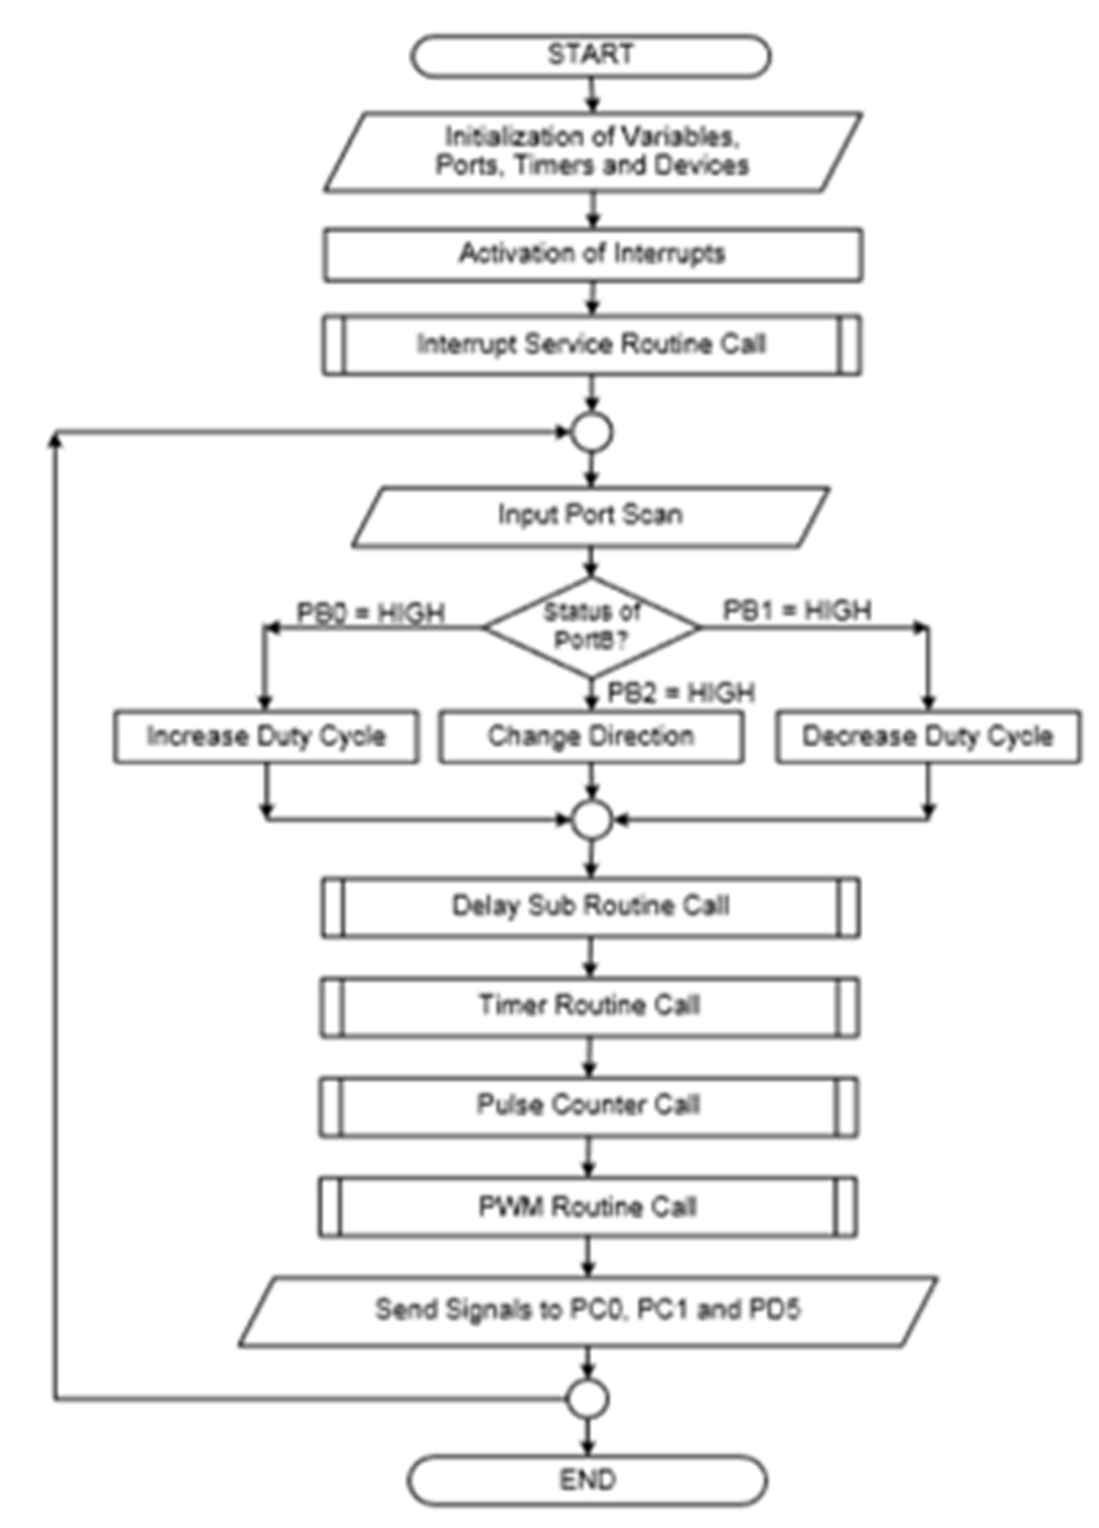
Figure 5. Flow chart of purposed